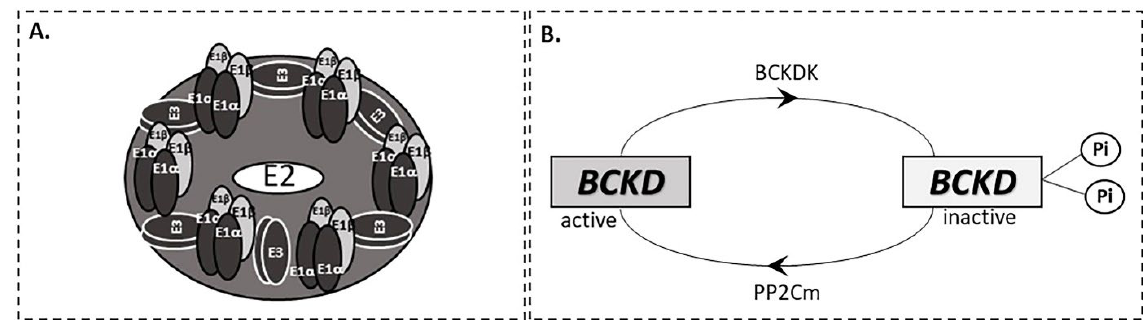
Figure 2. (A ) BCKD complex. ( B ) Regulation of the BCKD complex.